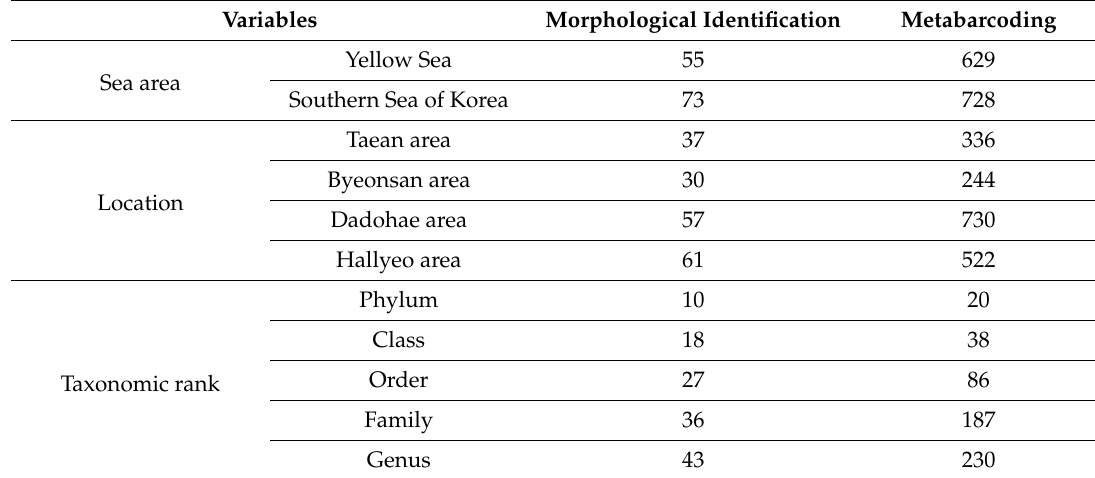
Table 2. The number of taxa analyzed by morphological identification and metabarcoding with mesozooplankton samples collected in the Marine and Coastal National Park areas of Korea. Variables Morphological Identification